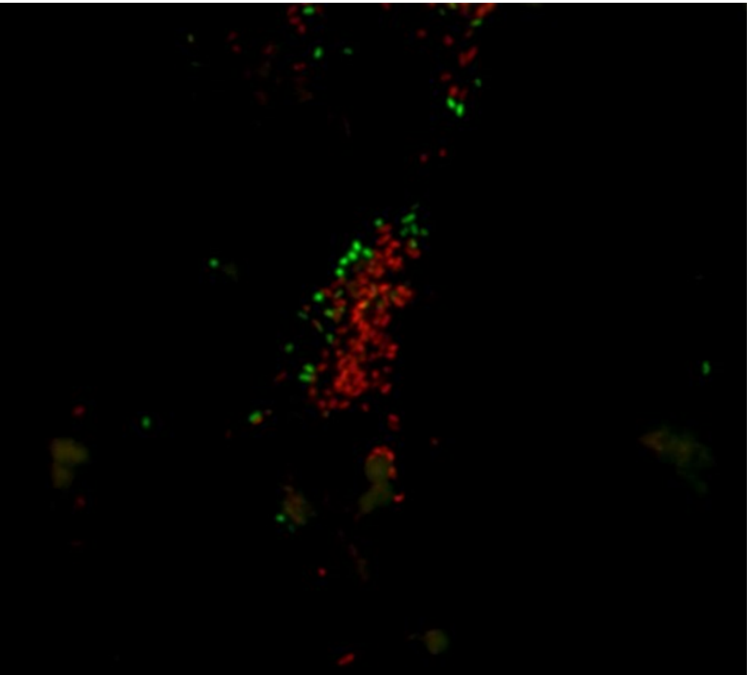
Figure 4. Planktonic state of Pseudomonas fluorescens stained with LIVE/DEAD (SYTO 9 and propid- ium iodine) after treatment with peracetic acid (250 ppm) for 15 min. Viable bacteria (green) and damaged bacteria (red). Magnification × 100.